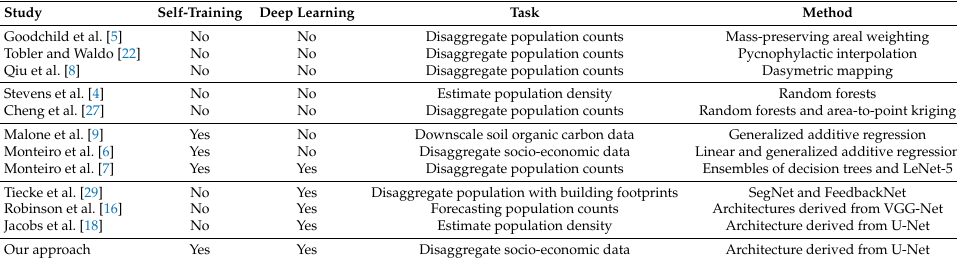
Table 1. The spatial disaggregation approaches that have been